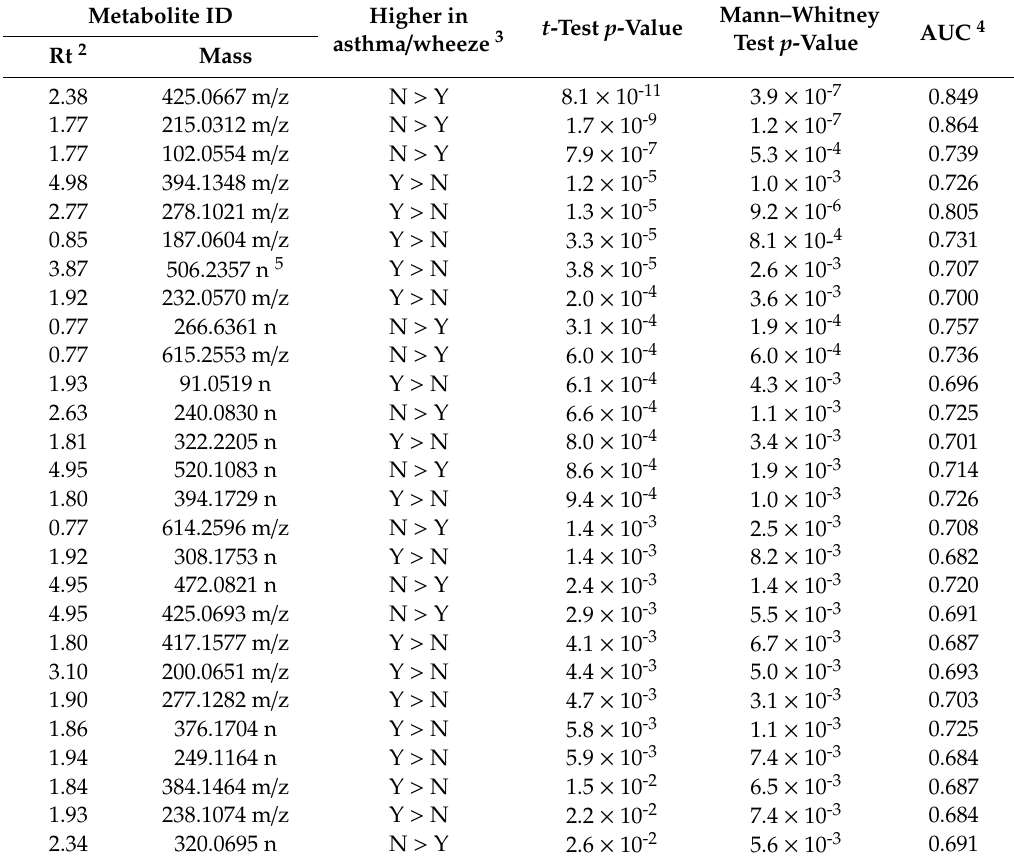
Table 1. Univariate data analysis results for COPSAC2000 1